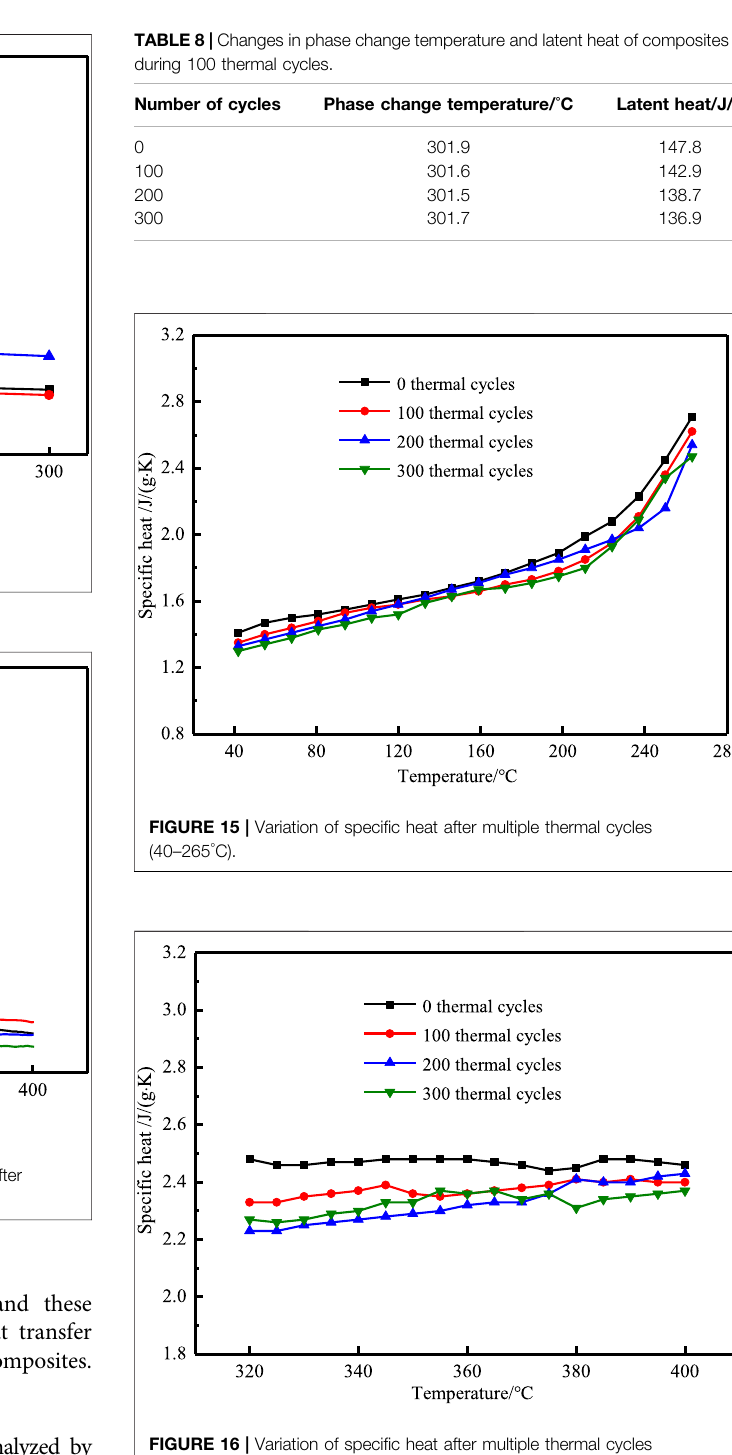
FIGURE 16 | Variation of speci fi c heat after multiple thermal cycles (320 – 400 °